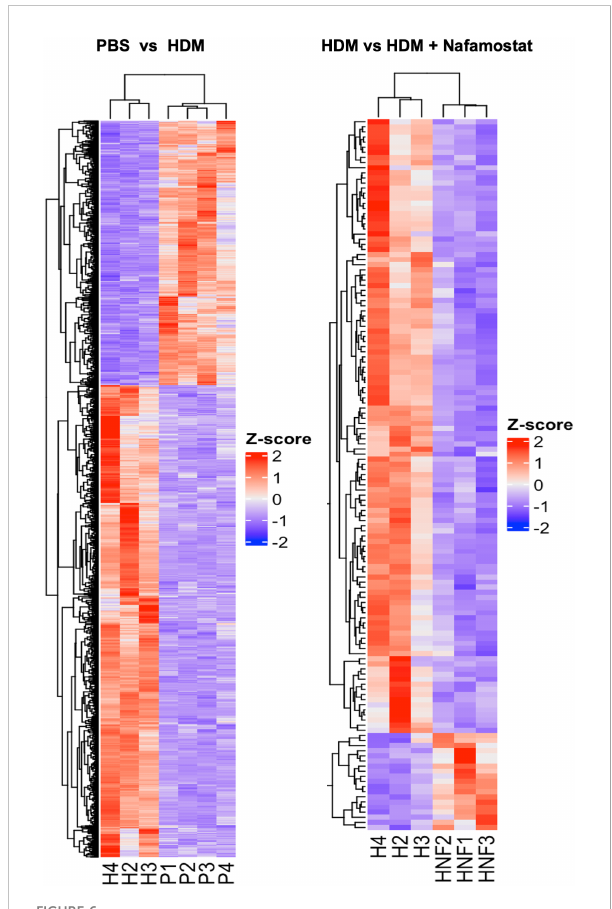
FIGURE 6 Heatmap constructed with hierarchical clustering to compare gene expression patterns in the control- (PBS) vs. HDM and the HDM vs. HDM + nafamostat (20 mg/kg) groups. n = 3 – 4 mice per group. HDM, house dust mite. n = 3 – 4 mice per group. HDM, house dust